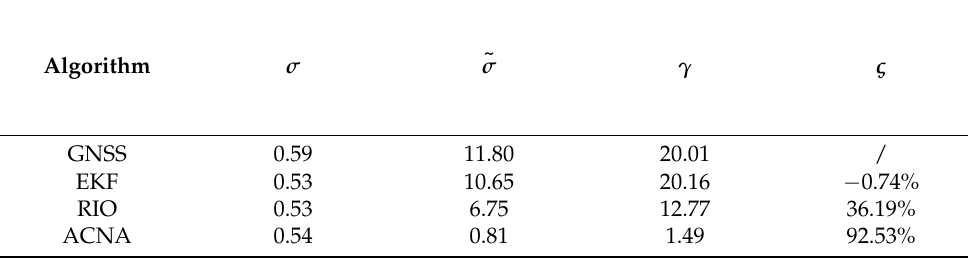
Table 6. σ , γ and ς for the three